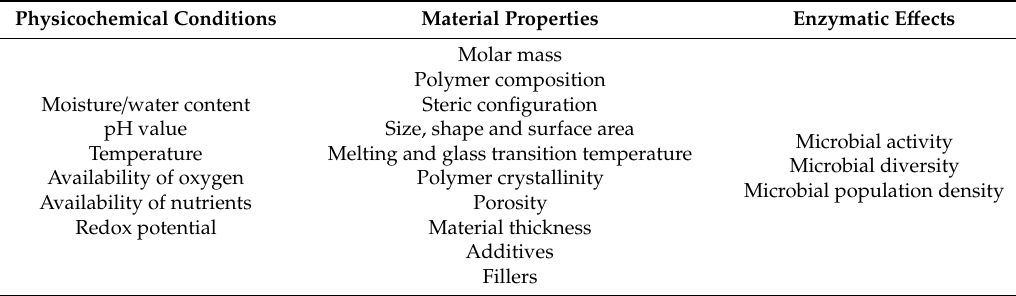
Table 1. Major influential factors for biological